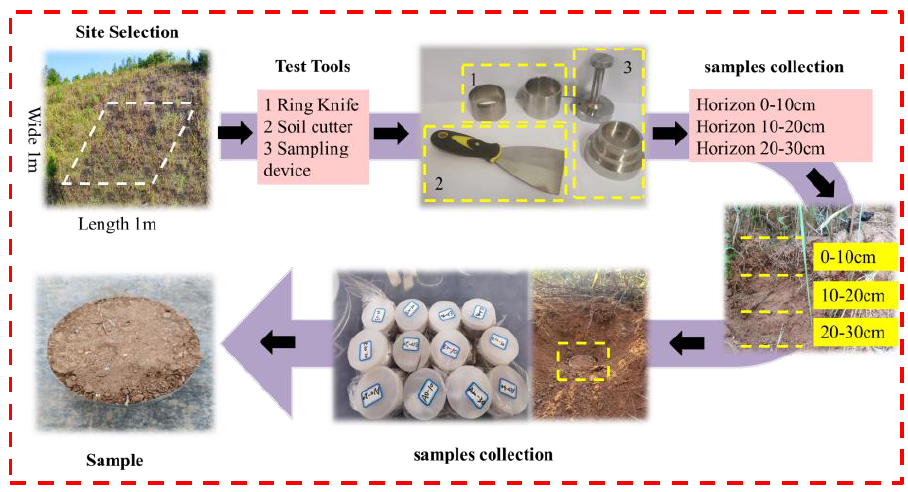
Figure 3. Sampling process.